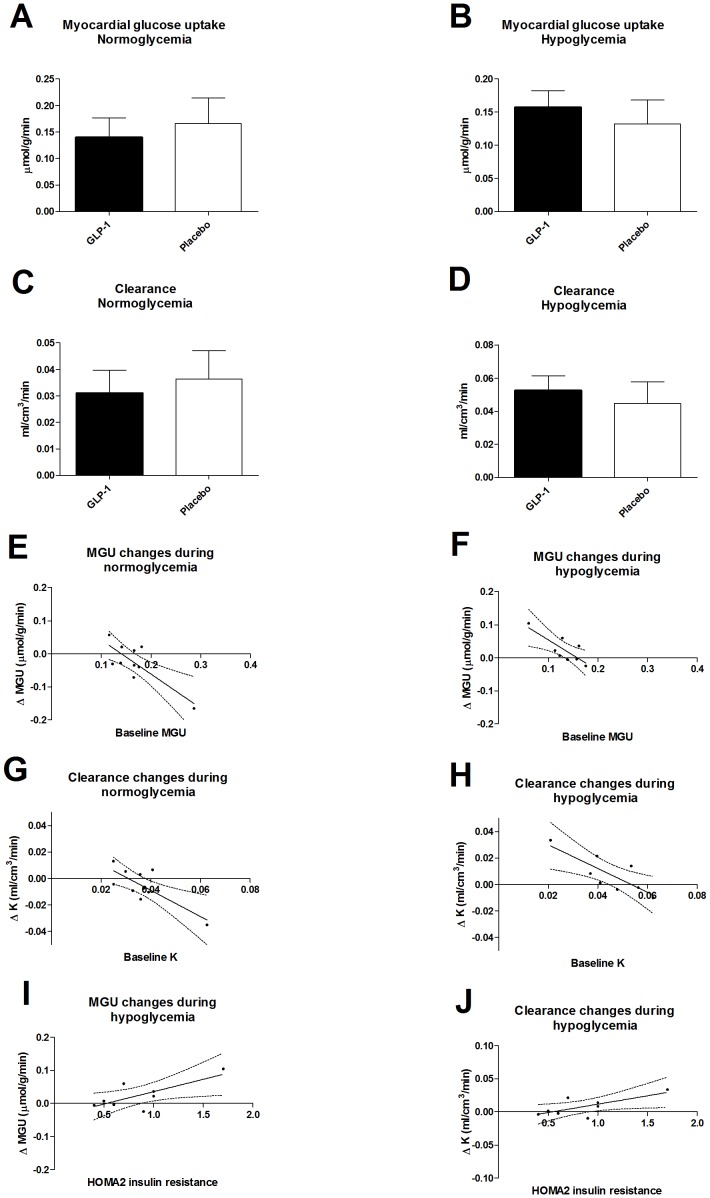
Positron emission tomography.Myocardial glucose uptake (MGU) during normoglycemia and hypoglycemia (A and B). 18F-FDG clearance (K) during normoglycemia and hypoglycemia (C and D). Relation between placebo MGU and change in MGU during GLP-1 infusion in the normoglycemia study (E), placebo MGU and change in MGU during GLP-1 infusion in the hypoglycemia study (F). Relation between placebo K and change in K during GLP-1 infusion in the normoglycemia study (G), placebo K and change in K during GLP-1 infusion in the hypoglycemia study (H). HOMA 2IR and the change of MGU during GLP-1 infusion in the hypoglycemia study (I). HOMA 2IR and the change of K during GLP-1 infusion in the hypoglycemia study (J). Data are mean ± SD. Regression lines with 95% confidence intervals.